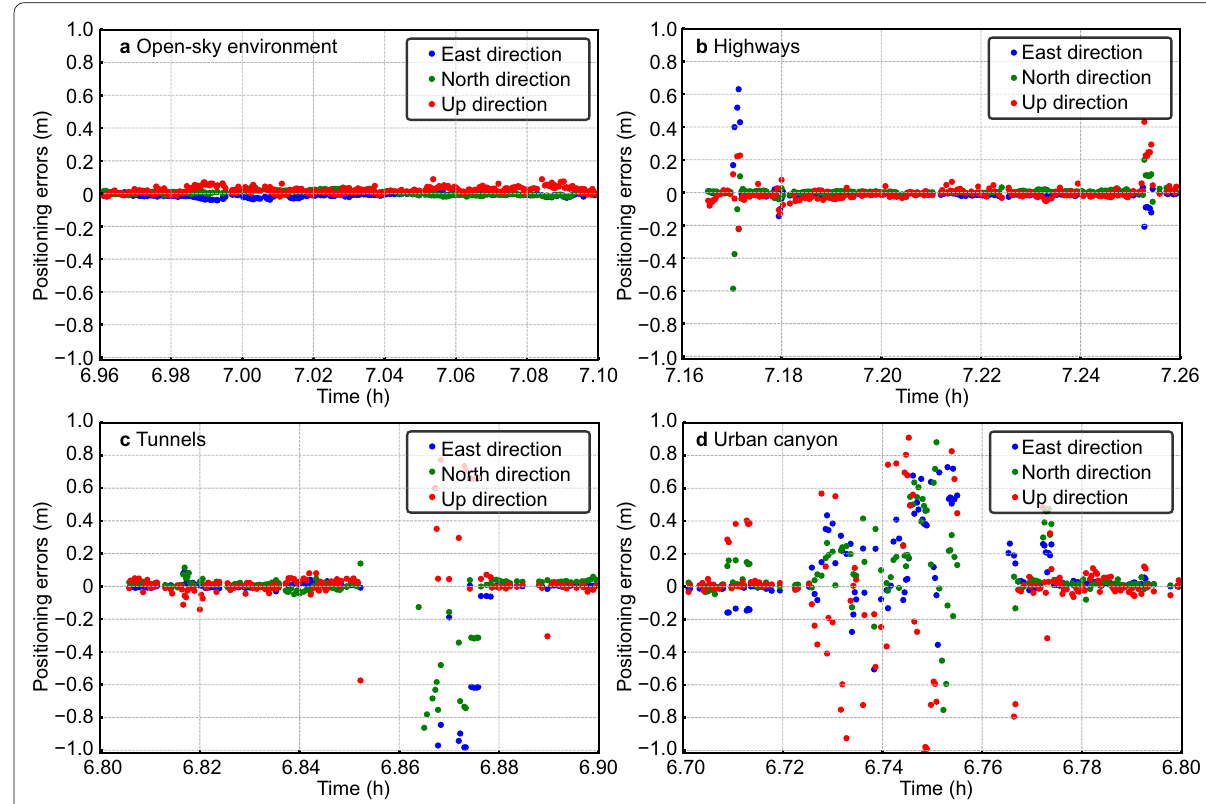
Fig. 7 Positioning error series of the PPP-RTK in different scenes